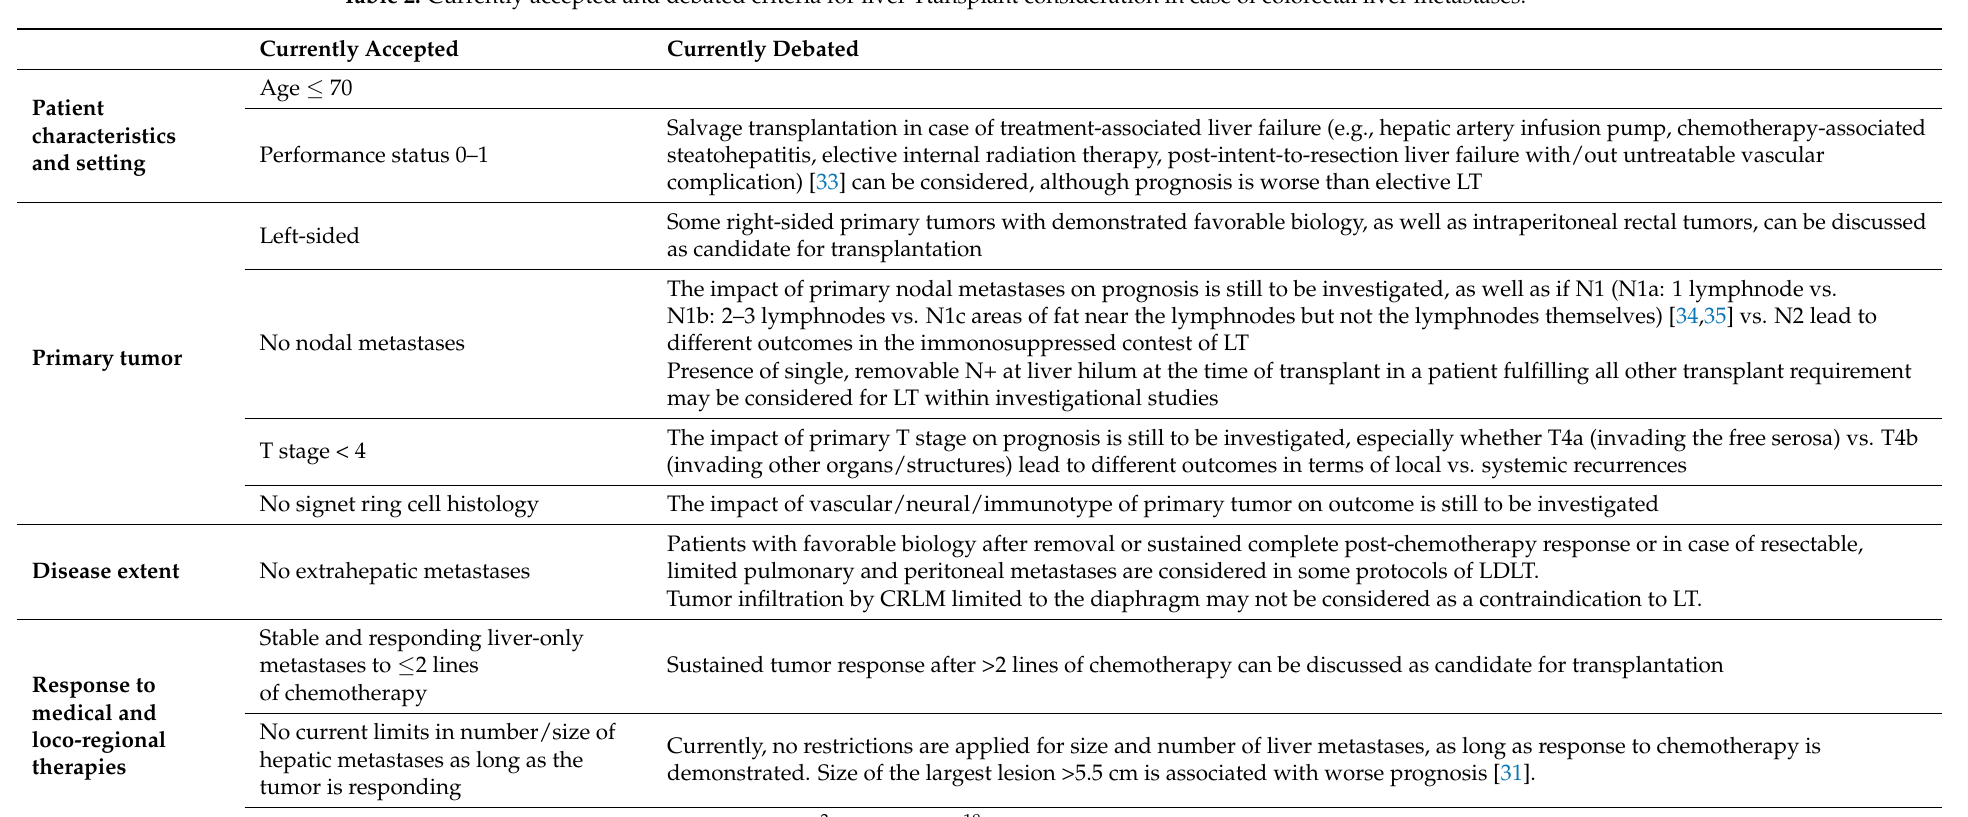
Table 2. Currently accepted and debated criteria for liver Ttansplant consideration in case of colorectal liver